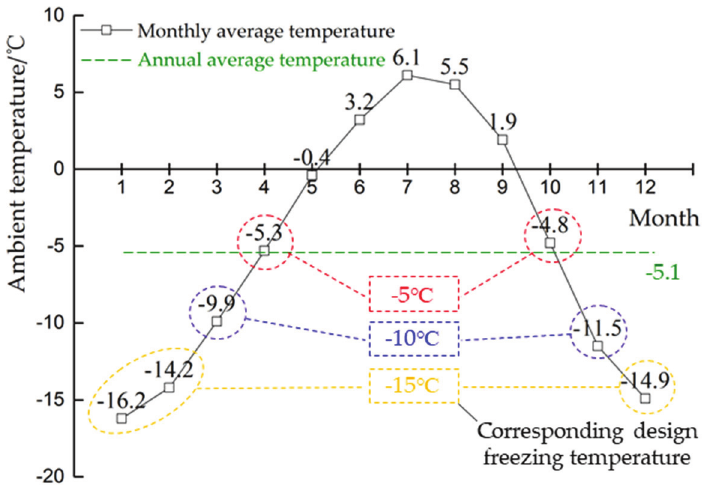
Figure 6. Ambient temperatures in Hailar, Inner Mongolia, China.